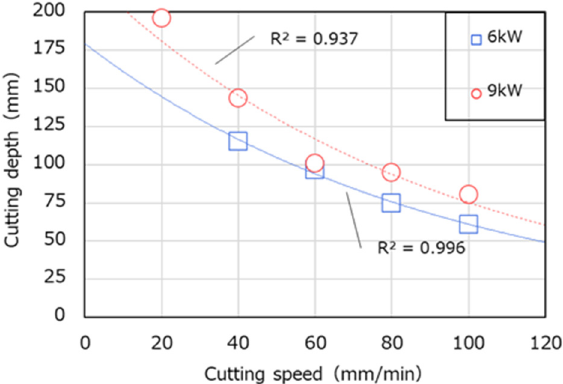
Figure 3. Relationship between the cutting speed and cutting depth for the two laser powers (compressive strength 20 N/mm 2 ).